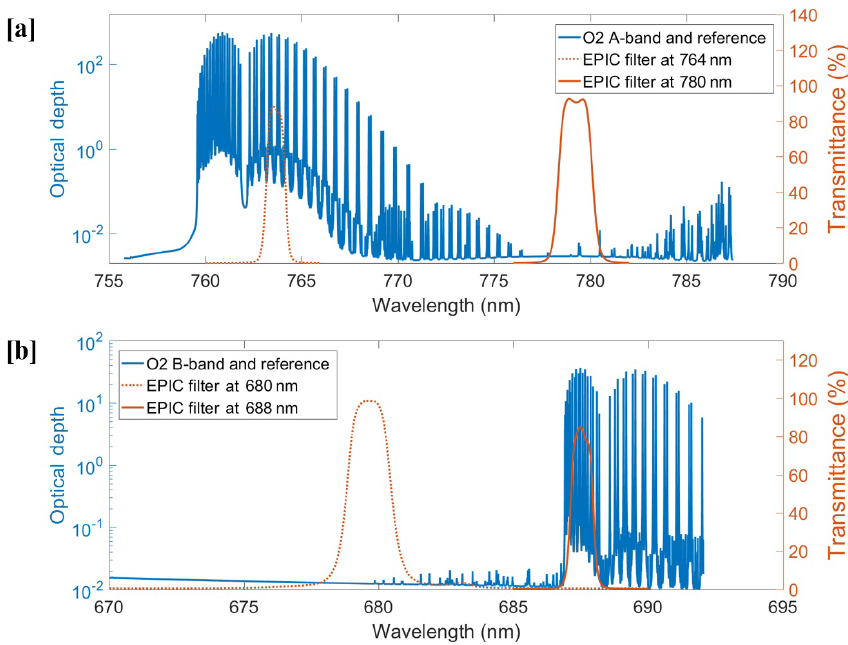
Figure 1. High-resolution calculated absorption optical depth spectrum at the oxygen A band (a) and B band (b) with DSCOVR EPIC oxygen A- and B-band in-band and reference filters. Here the absorption optical depth spectrum is calculated by the LBLRTM model with the HITRAN 2016 database for the US standard